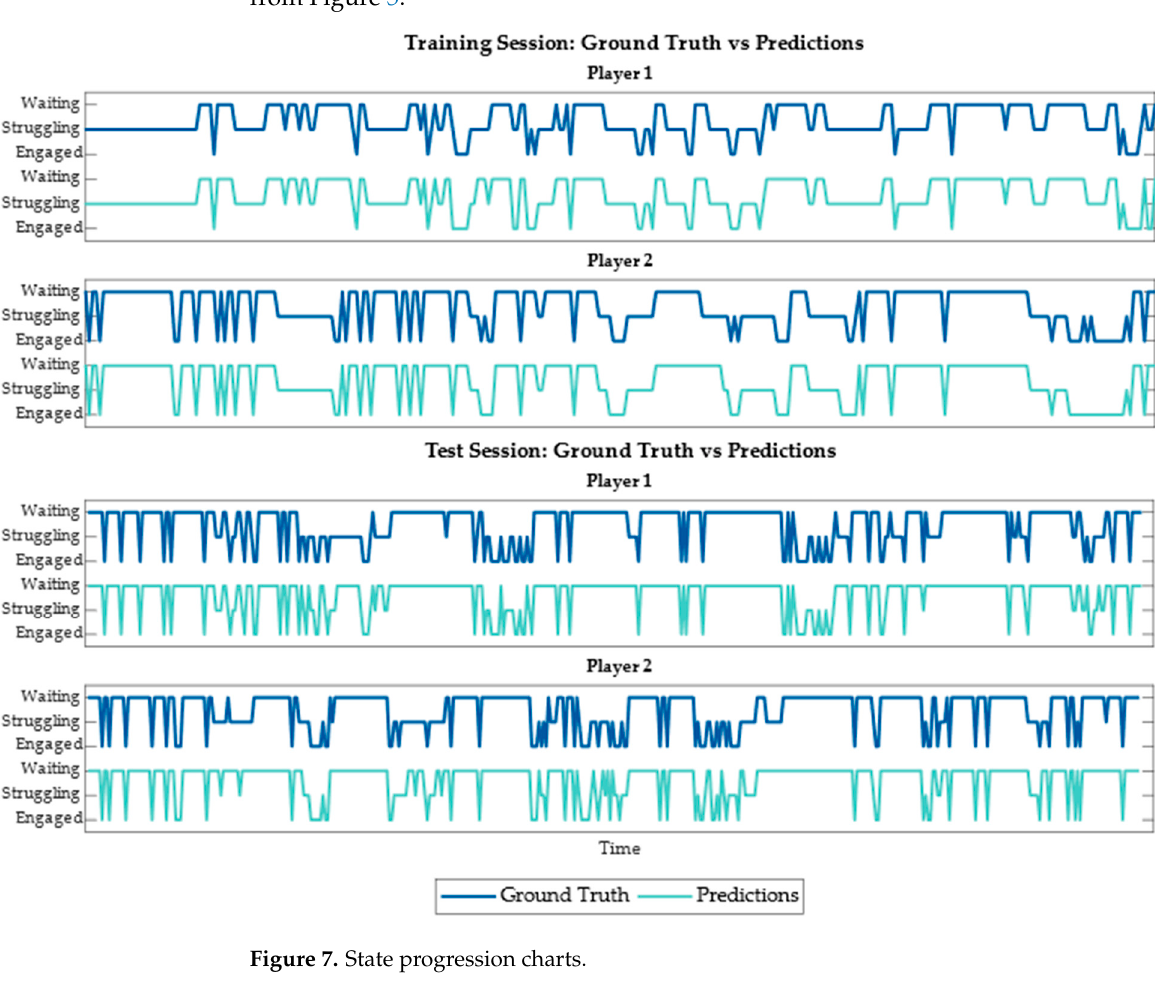
Figure 7. State progression charts.